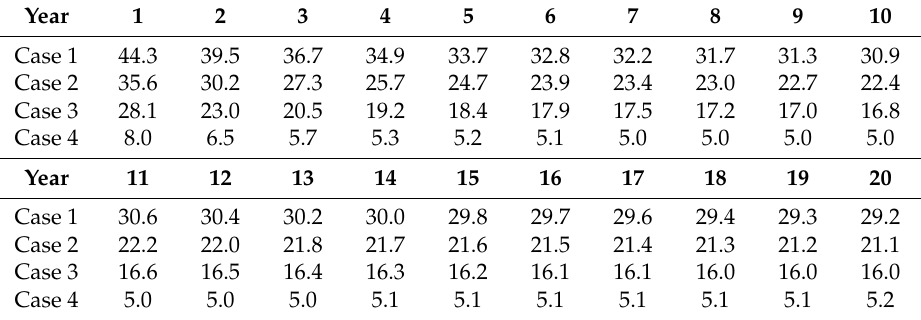
Table 3. Calculated results of soil thermal imbalance ratio with 4 cases (%).